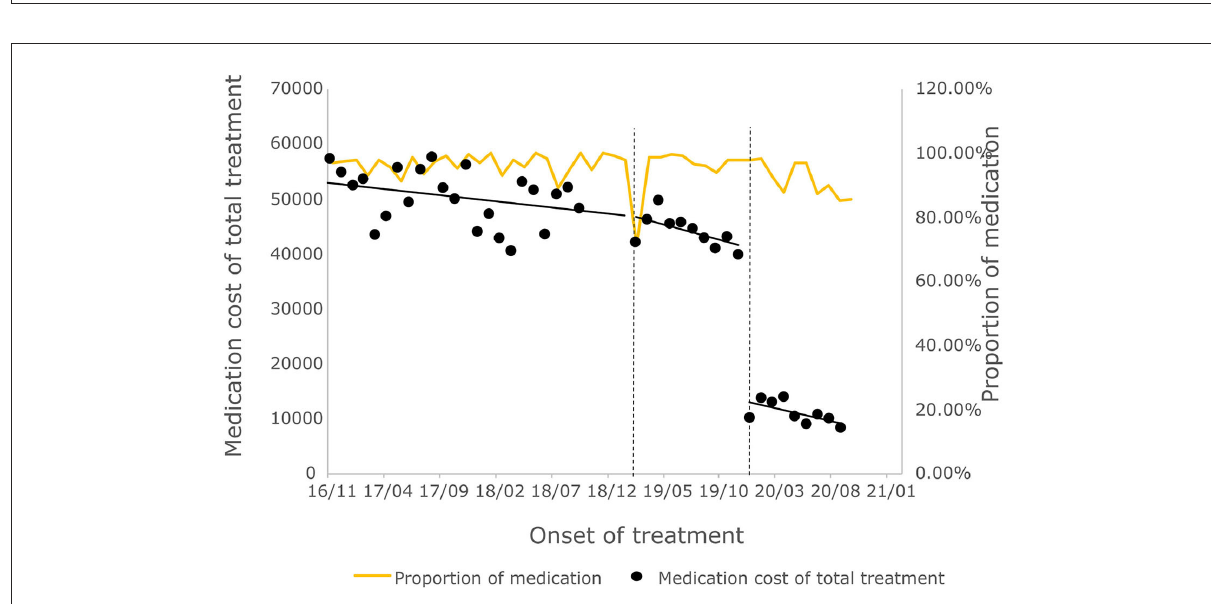
FIGURE6 Medication cost and proportion of medication cost in total treatment for hepatitis C